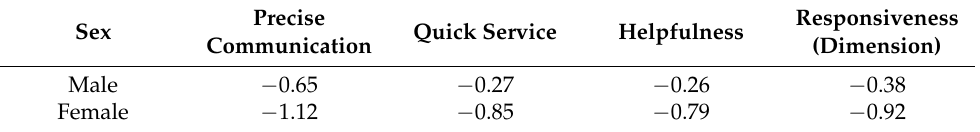
Table 6. Average service quality score for males and females in relation to features of responsiveness. Differences between groups are significant ( p < 0.05) on all items except precise